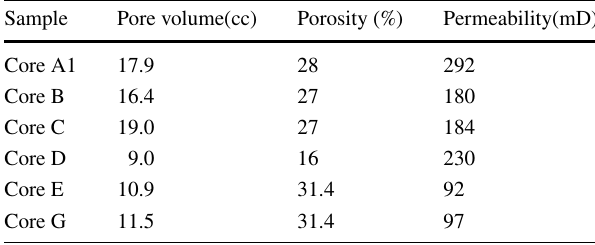
Table 1 Physical properties of core samples saturated at